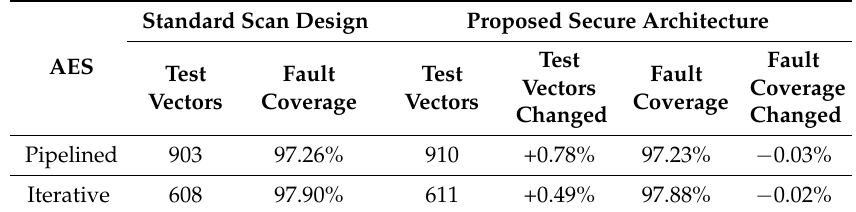
Table 2. Test effectiveness results for standard scan design and proposed secure